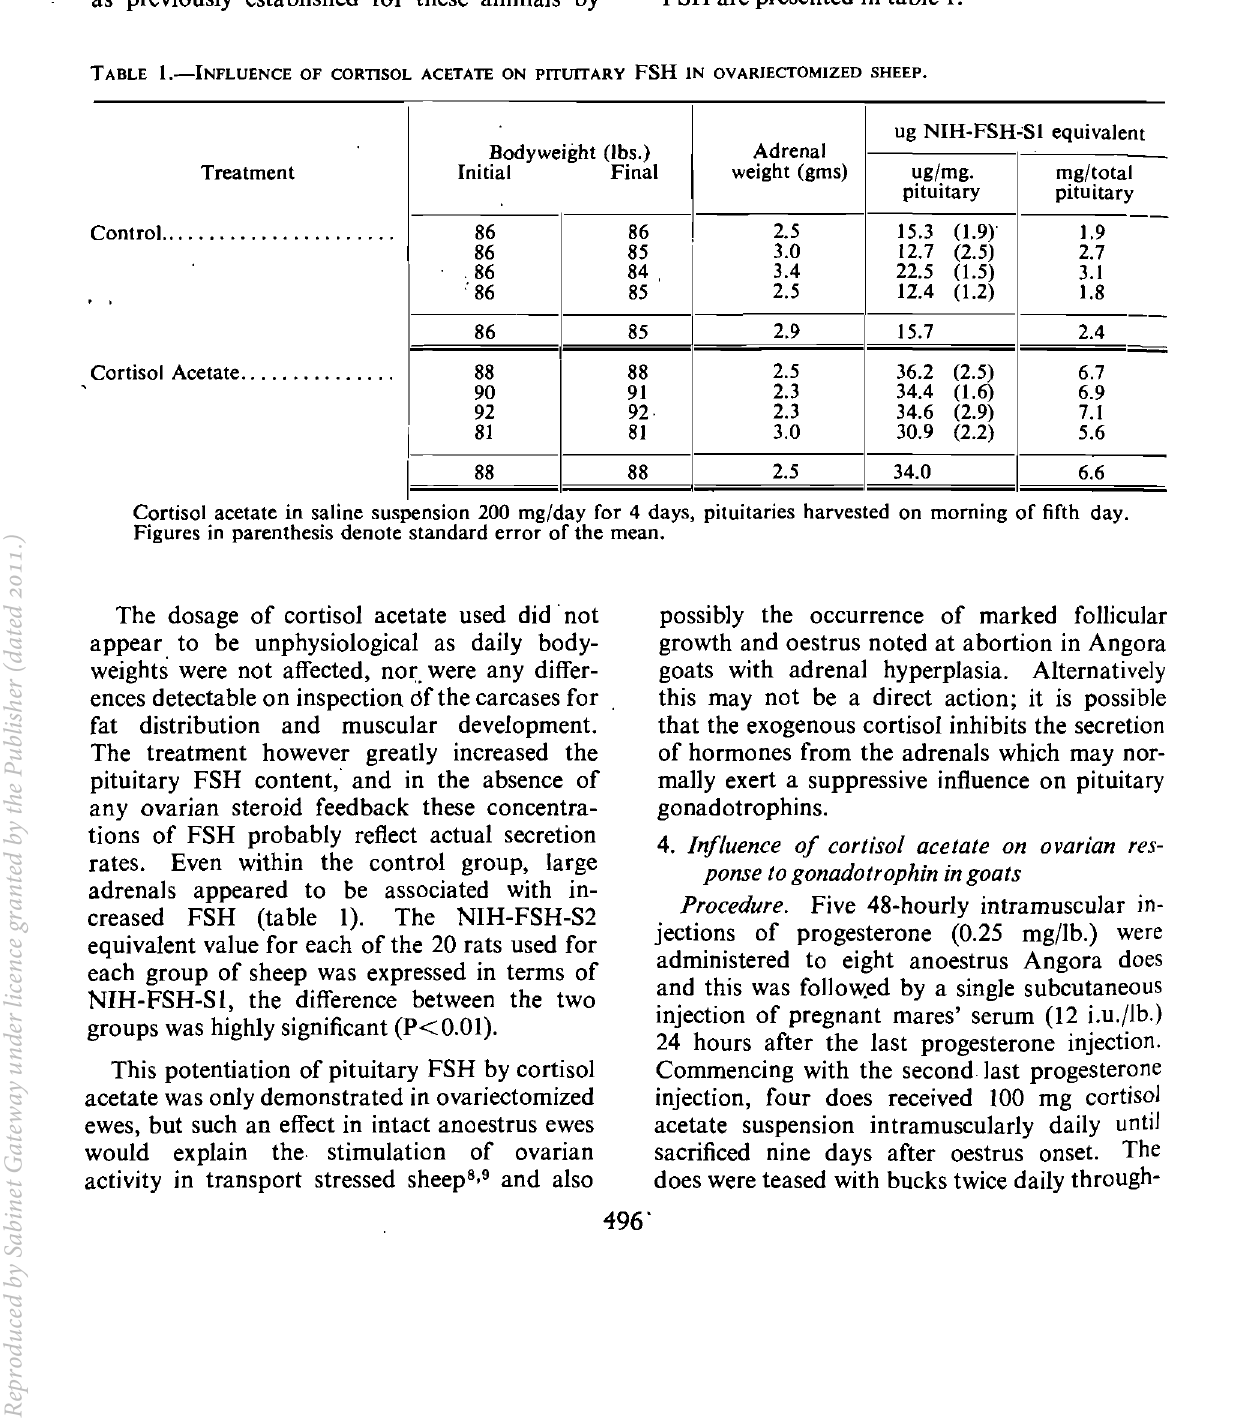
TABLE I.-INFLUENCE OF CORTISOL ACETATE ON PITUITARY FSH IN OVARIECTOMIZED SHEEP. ug NIH-FSHcSI equivalent Bodyweight